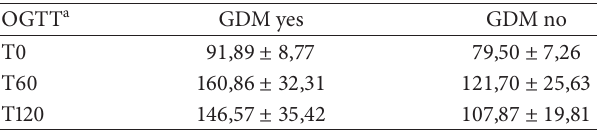
Table 2: OGTT values of cases and controls. OGTT a GDM